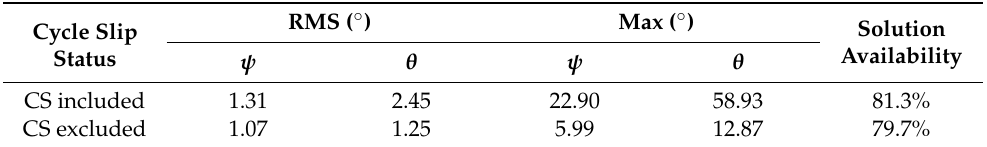
Table 4. RMS, absolute maximum error, and solution availability of heading and pitch estimates from TDCP with and without cycle